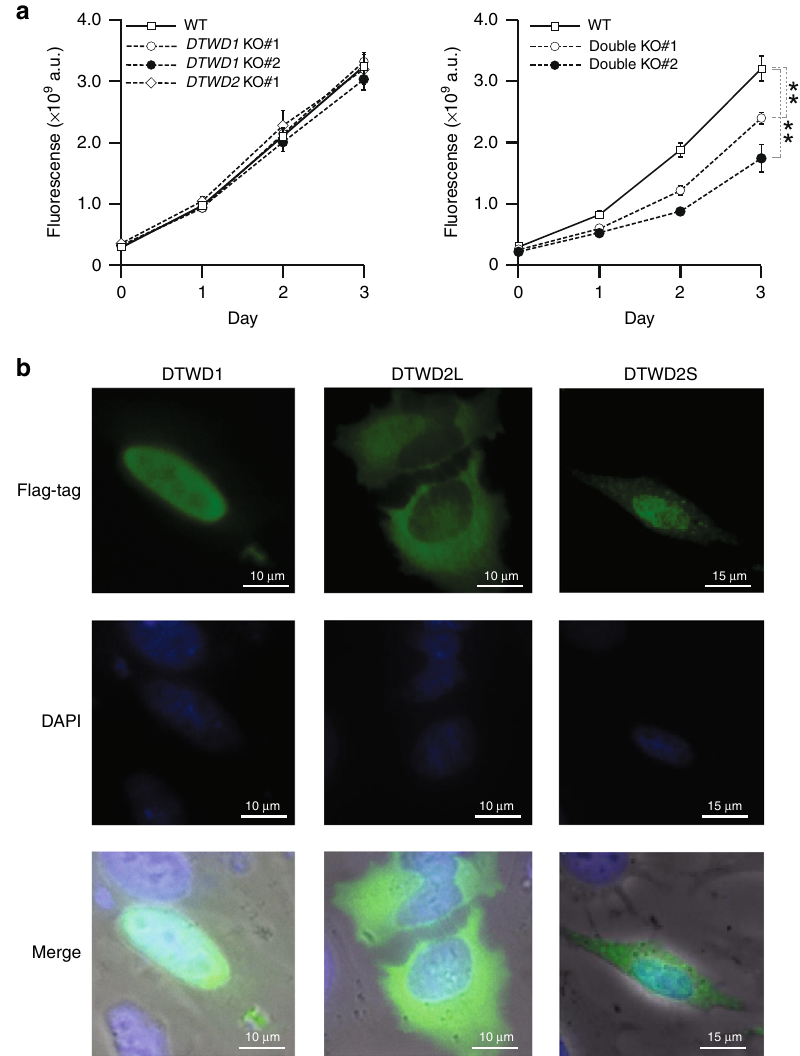
Fig. 5 Physiological role and subcellular localization of DTWD1 and DTWD2. a Growth curves of WT HEK293T (open square), DTWD1 KO#1 (open circle), DTWD1 KO#2 (closed circle) and DTWD2 KO (open rhombus) strains (left panel), and WT HEK293T (open square), DTWD1 / DTWD2 double- KO#1 (open circle) and DTWD1 / DTWD2 double-KO#2 (closed circle) strains (right panel), cultured in DMEM medium. Fluorescence was calculated as the average values of biological replicates ( n = 6), with s.d. ** P < 8.1 × 10 − 6 by Student ’ s t test. Source data are provided as a Source Data fi le. b Subcellular localization of DTWD1 (left panels), DTWD2L (middle panels), and DTWD2S (right panels) in HeLa cells immunostained with an anti-FLAG antibody (green). Nuclei were stained with DAPI (blue). Images were superimposed to generate the merged